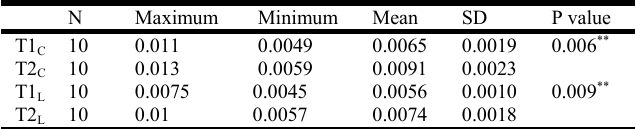
Table 1. Comparision of DSPP values (ngL -1 ) in GCF